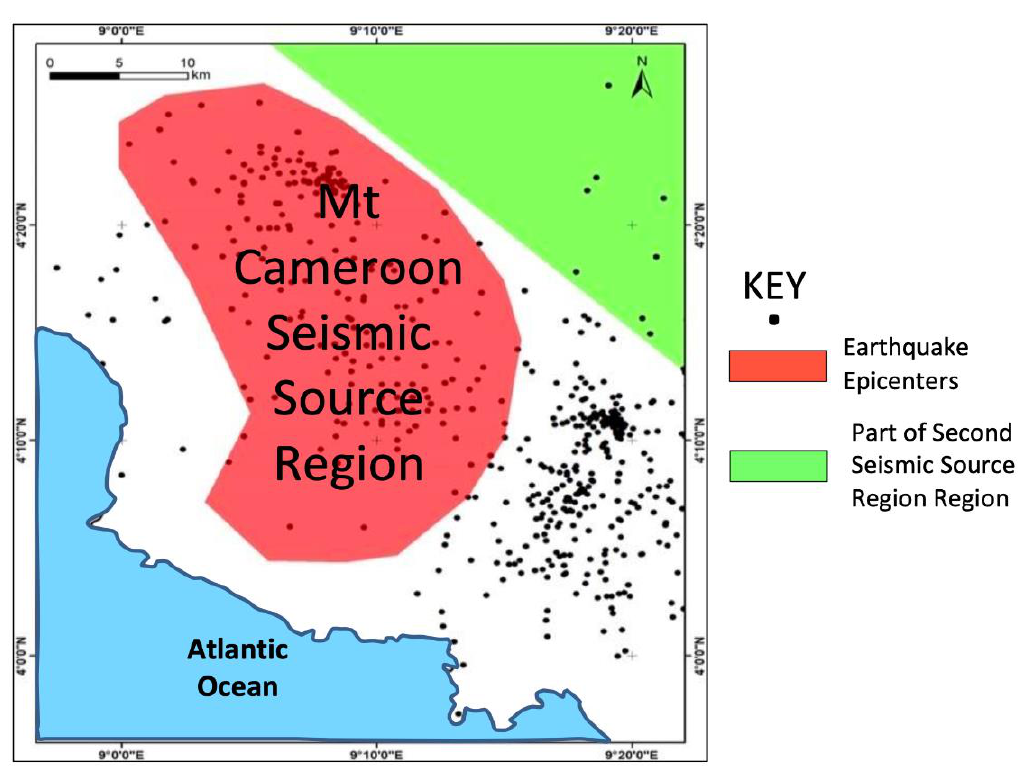
Figure 4. First seismic source region around Mt. Cameroon. Source: [66].